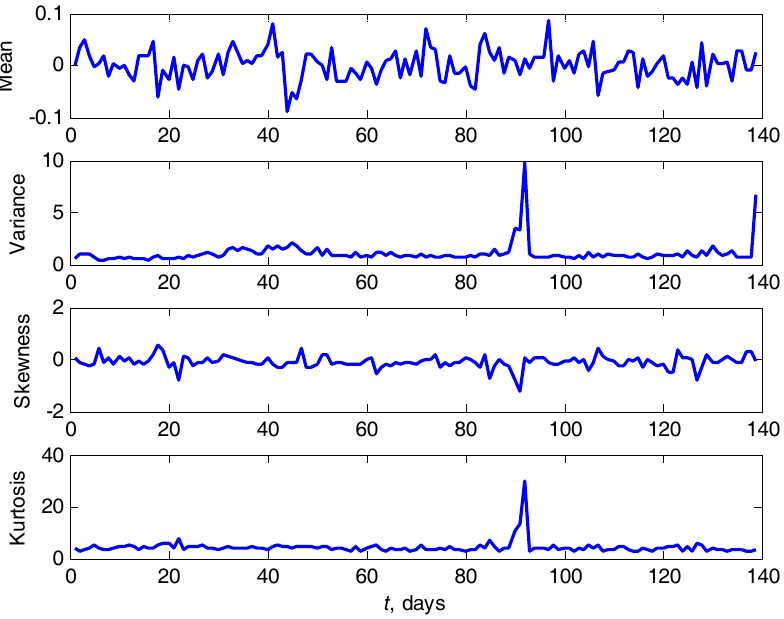
Figure 17. Statistical-based features calculated from EMD decomposition.